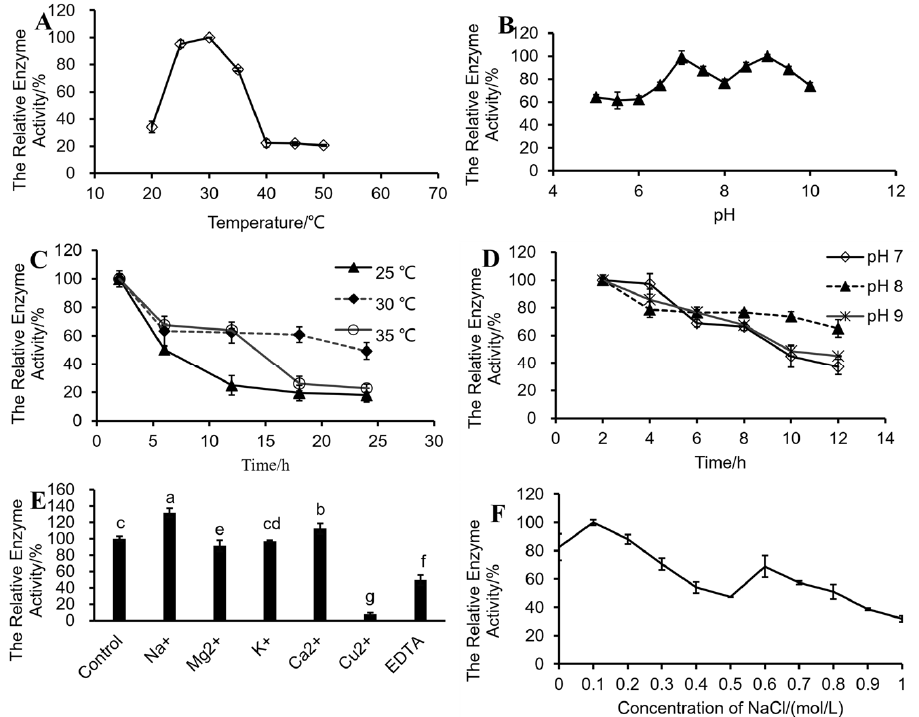
Figure 5. Effects of temperature, pH and metal ions on fucoidanase HN-25-M activity. ( A ) Effects Figure 5. E ff ects of temperature, pH and metal ions on fucoidanase HN-25-M activity. ( A ) E ff ects of of temperature on enzymatic activity. ( B ) Effects of pH values on enzymatic activity. ( C ) Effects of temperature on enzymatic activity. ( B ) E ff ects of pH values on enzymatic activity. ( C ) E ff ects of different temperature on stability on enzymatic activity. ( D ) Effects of different pH values on stability di ff erent temperature on stability on enzymatic activity. ( D ) E ff ects of di ff erent pH values on stabil- on enzymatic activity. ( E ) Effects of different metal ions and EDTA on enzymatic activity. ( F ) Effects ity on enzymatic activity. ( E ) E ff ects of di ff erent metal ions and EDTA on enzymatic activity. ( F ) of different concentrations of NaCl on enzymatic activity. The same letters of a~f mean the difference E ff ects of di ff erent concentrations of NaCl on enzymatic activity. The same le tt ers of a~f mean the among groups is not significant, and different letters represent significant differences ( p < di ff erence among groups is not signi fi cant, and di ff erent le tt ers represent signi fi cant di ff erences ( p < 0.05).